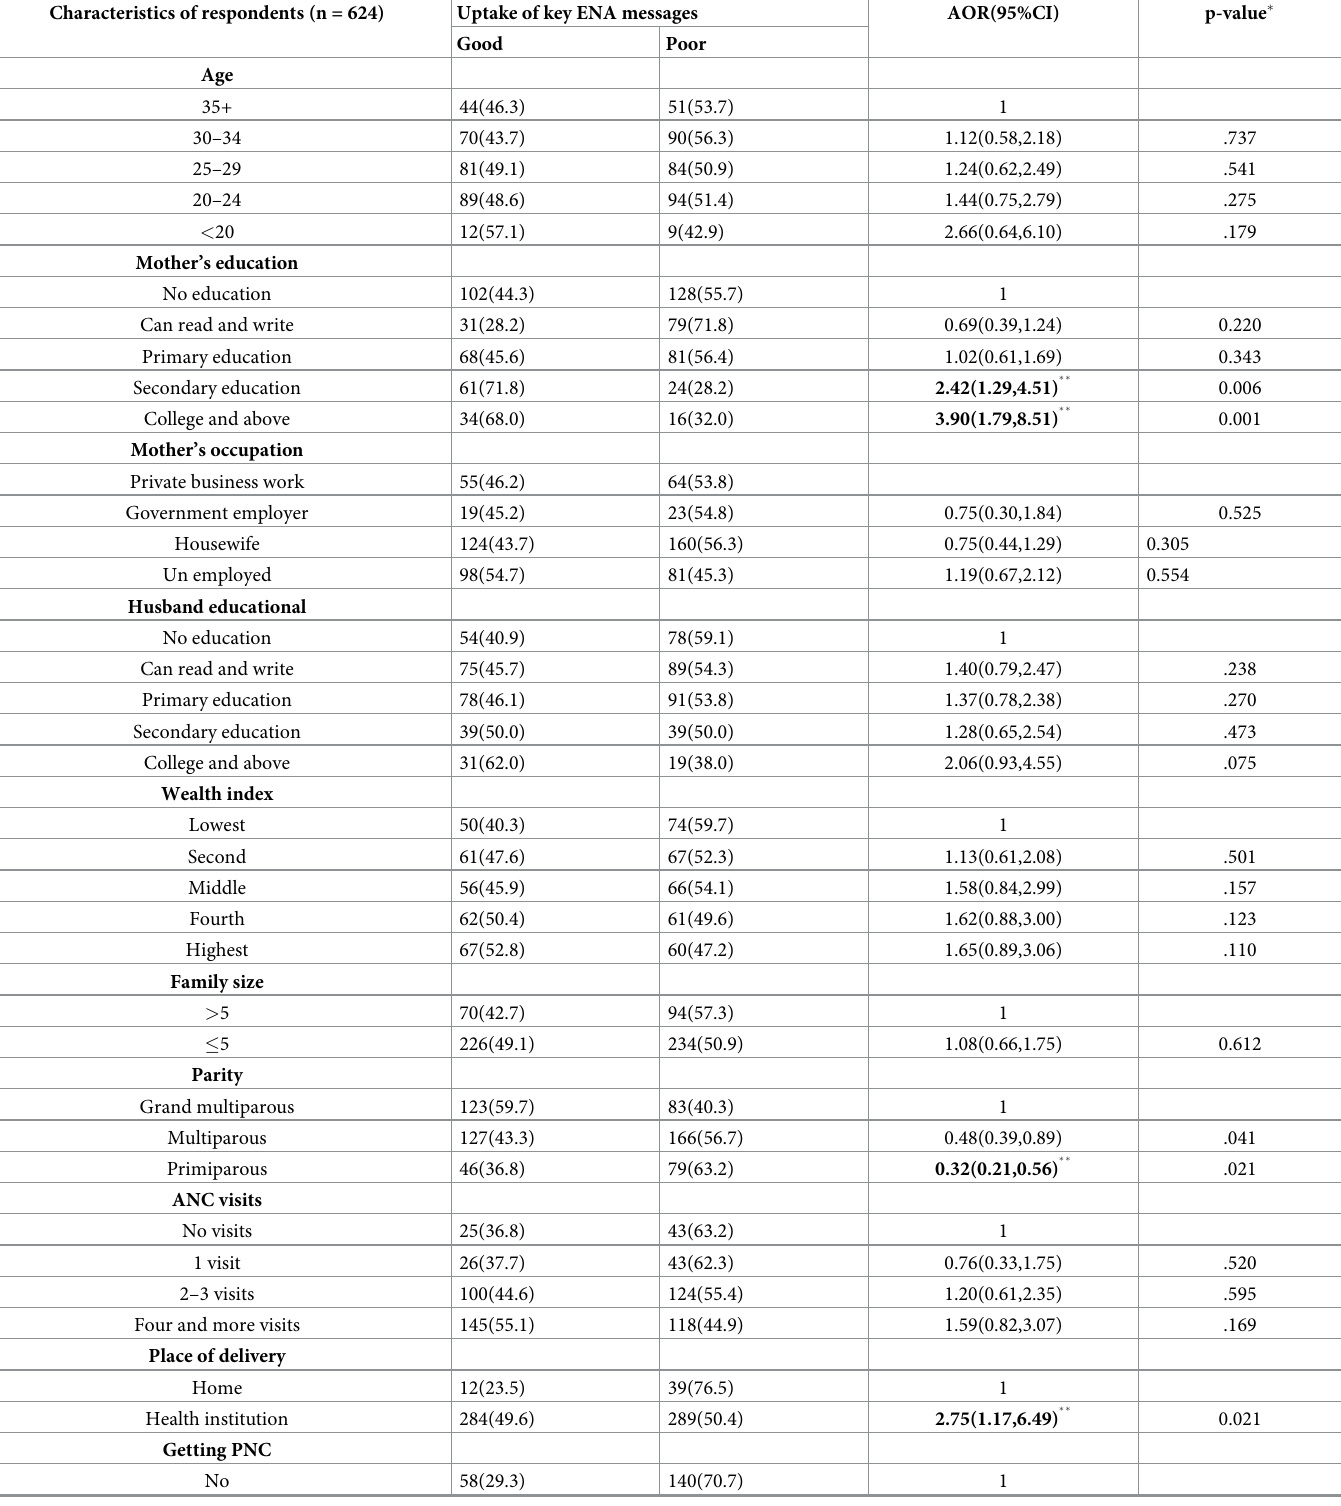
Table 5. Determinants of the practice of key ENA messages among mothers of children aged 6–24 months in Lemo District, Southern Ethiopia, 2021. Characteristics of respondents (n =